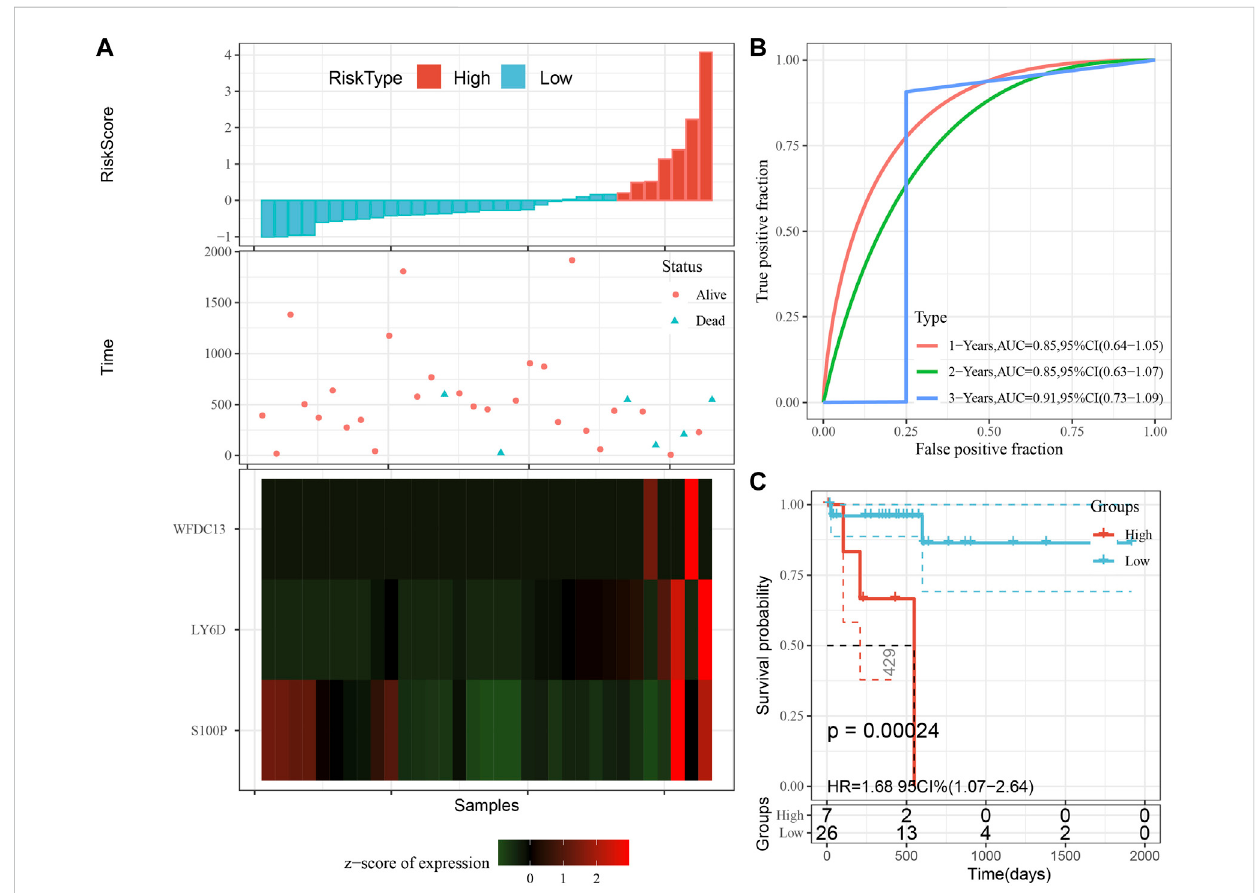
FIGURE 11 Validation of prognostic gene signatures in external datasets. (A) Risk score, survival time vs. survival status and expression of the 3 genes; (B) ROC curve and AUC for the 3-gene signature classi fi cation; (C) Distribution of KM survival curves of 3-gene signature in ICGC-PAAD